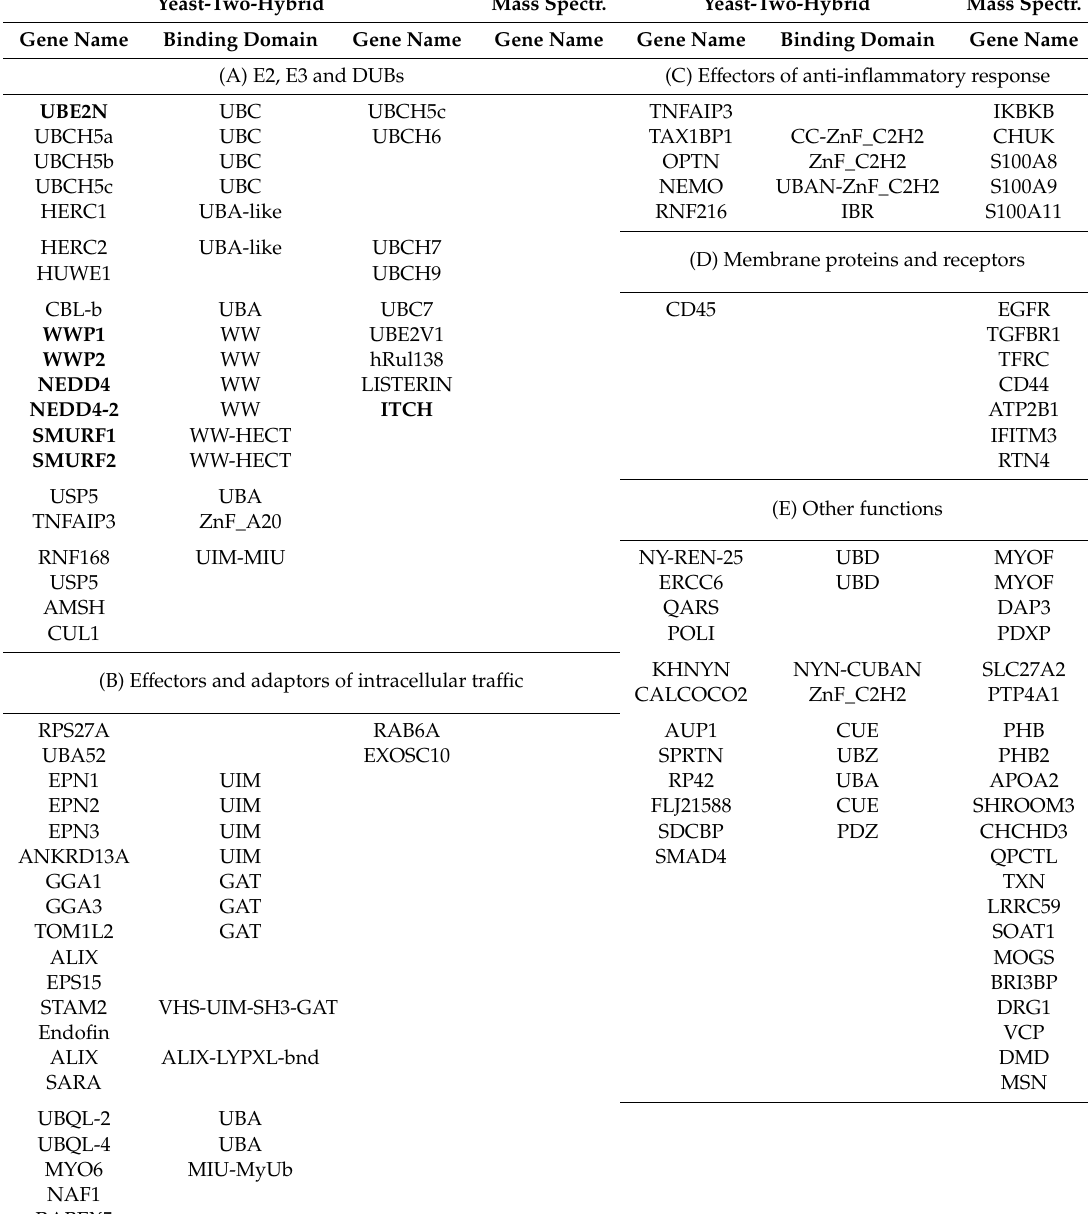
Table 2. List of RNF11 binding partners identified by Y2H-screeening (violet) and mass spectrometry (orange) experiments. When known, the domain selected in the Y2H screening is indicated. Proteins have been clustered according to their main biological role. Proteins that have been identified in both systems are shown in bold. Yeast-Two-Hybrid Mass Spectr. Yeast-Two-Hybrid Mass